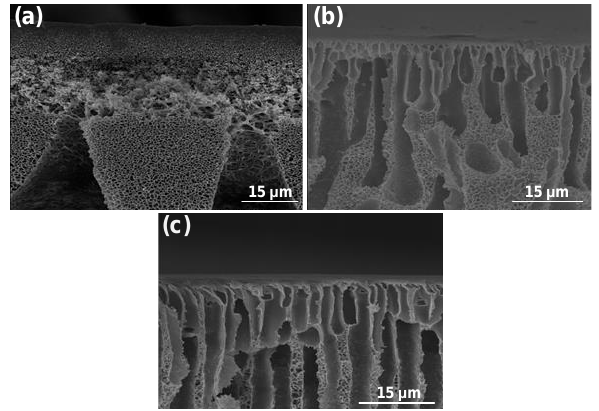
Figure 2. The e ff ect of solvent on polyether sulfone (PES) membrane structure: ( a ) dimethylacetamide Figure 2. The effect of solvent on polyether sufone (PES) membrane structure: ( a ) dimethylacetamide (DMAc),